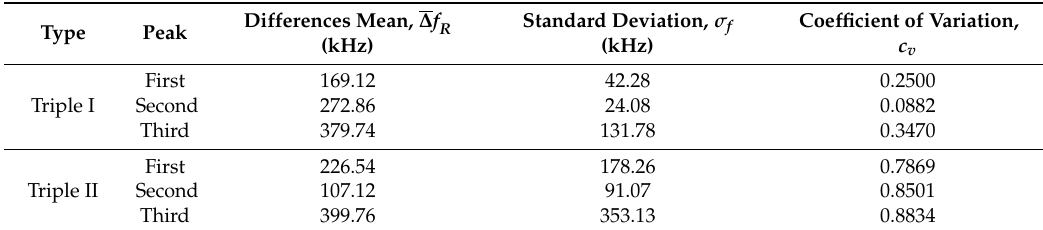
Table 5. Resonance frequency difference evaluation for triple series air